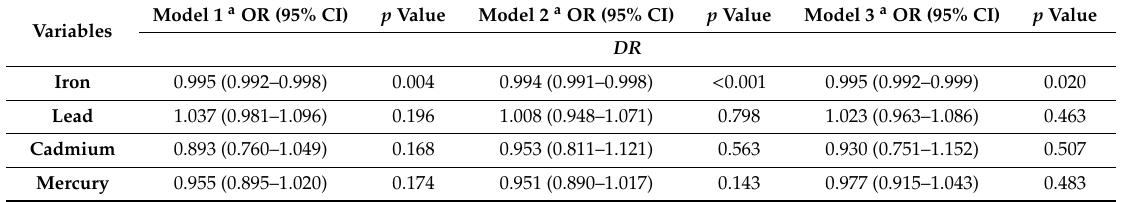
Association between iron, lead, cadmium, mercury, and the presence of diabetic retinopathy (DR).